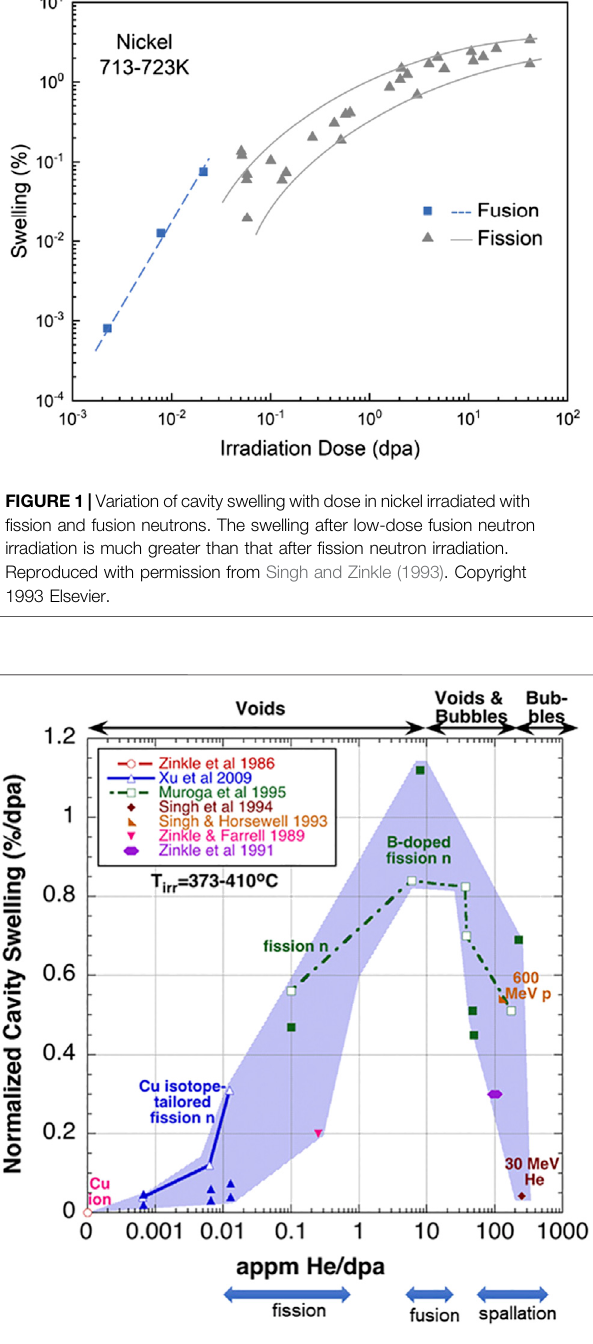
FIGURE 2 | The dependence of cavity swelling in pure Cu on the production rate of He. The dependence is nonmonotonic and a peak swelling occurs at about 10 appm He/dpa. (Bhattacharya and Zinkle, 2020).